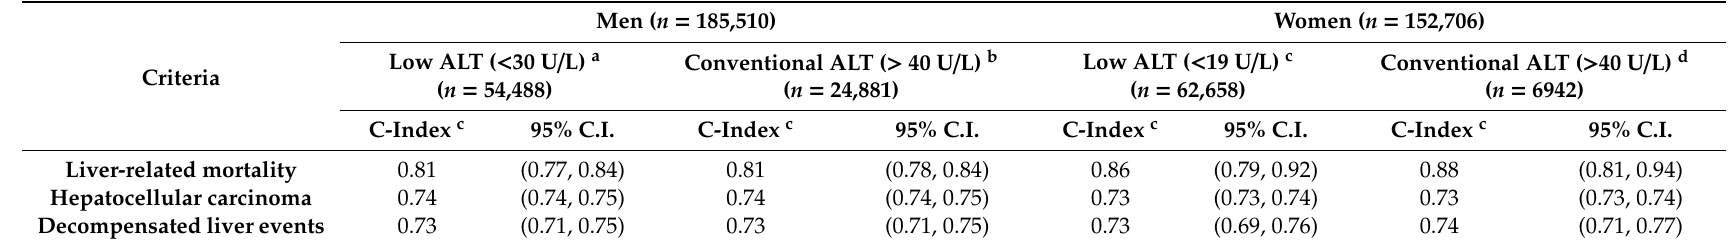
Table 3. Concordance statistic (C-index) value of each cuto ff value in men and